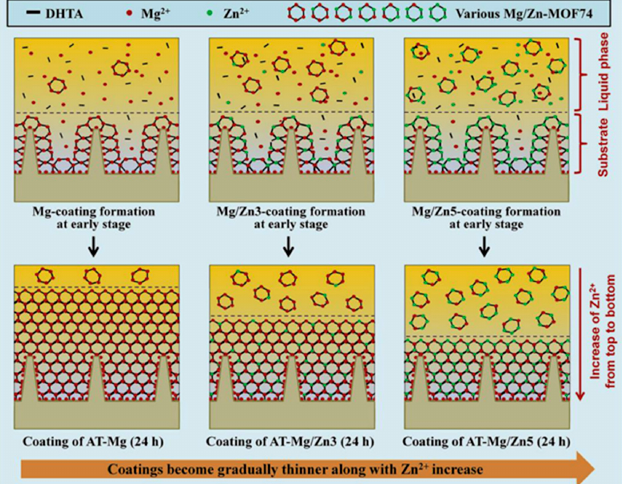
Figure 9. Illustration scheme of the formation of various Mg/Zn-MOF74 coatings on AT surfaces. Reproduced with permission from [73].